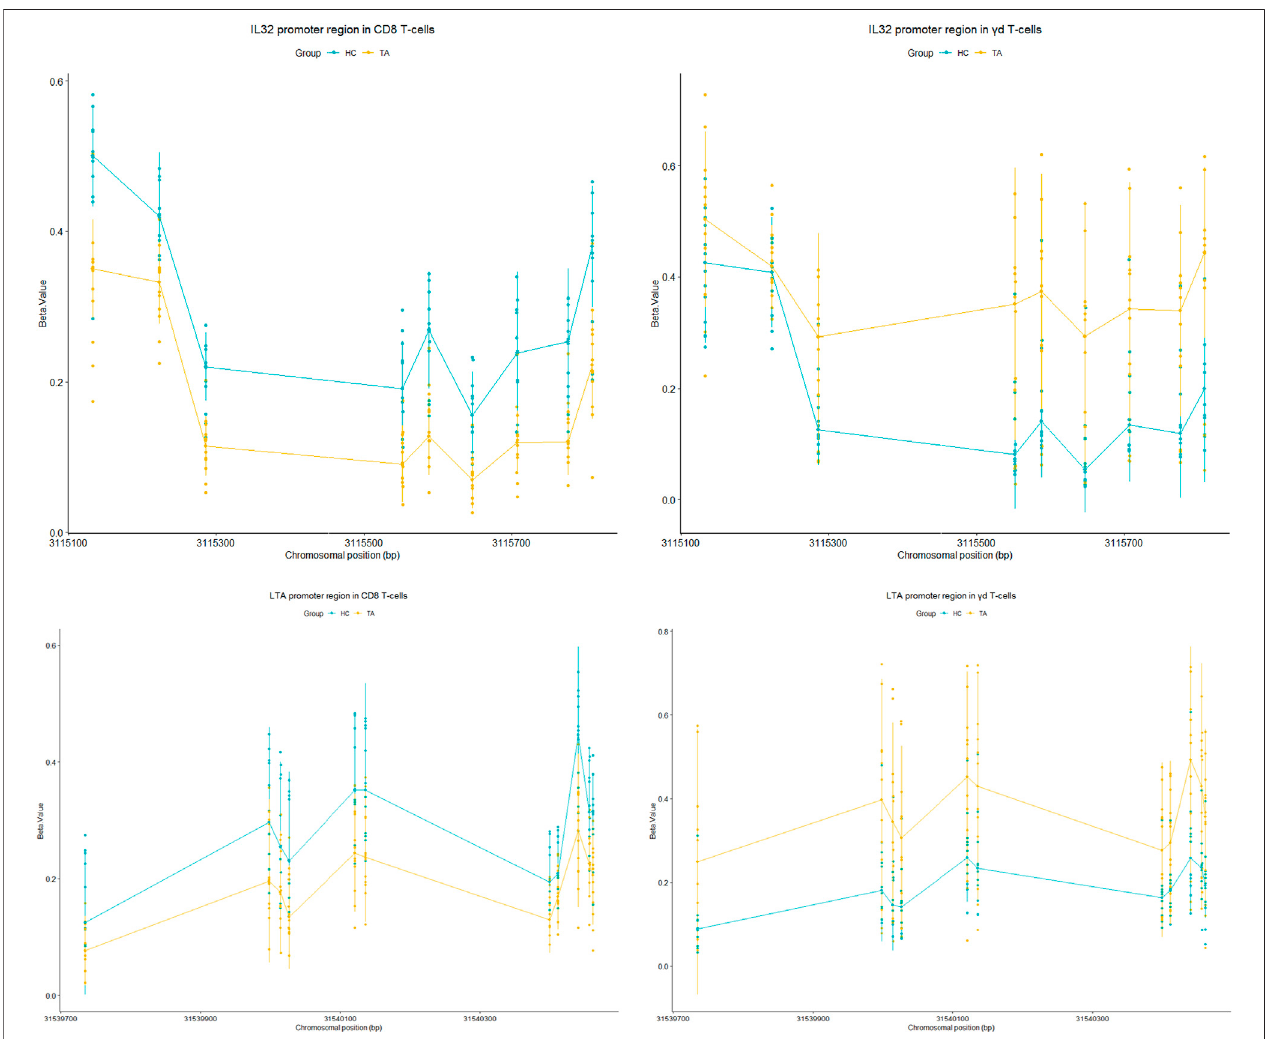
FIGURE 4 | Tukey plot showing signi fi cantly differentially methylated regions (CpG sites) in promoter region of IL-32 (chr 16: 3114847 – 3115809) and LTA (chr 6: 31539539- 31541349) genes in CD8 T cells and γδ T cells of TA as well as healthy controls. Both genes were hypomethylated in CD8 T cells and hypermethylated in γδ T cells of TA as compared to healthy